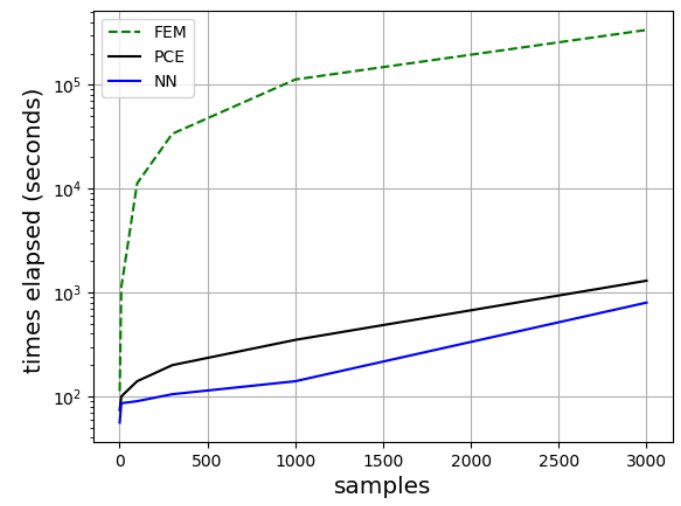
Figure 16. Computational efficiency for the displacements obtained by FEM, PCE and